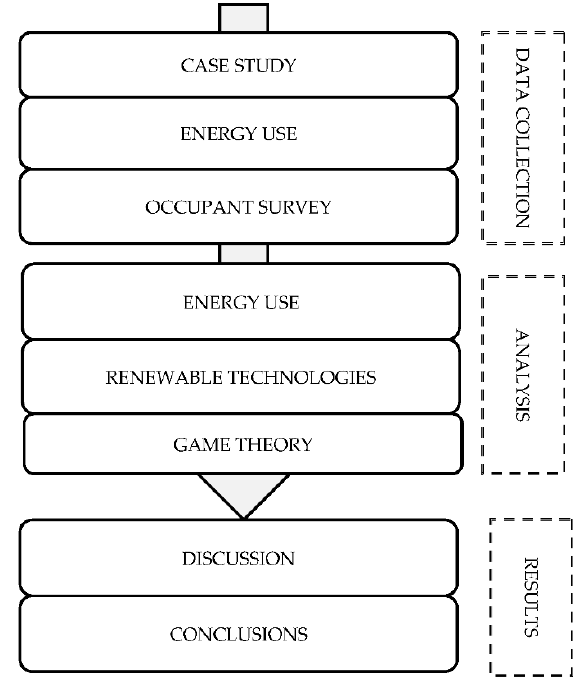
Figure 1. Research Methodology.